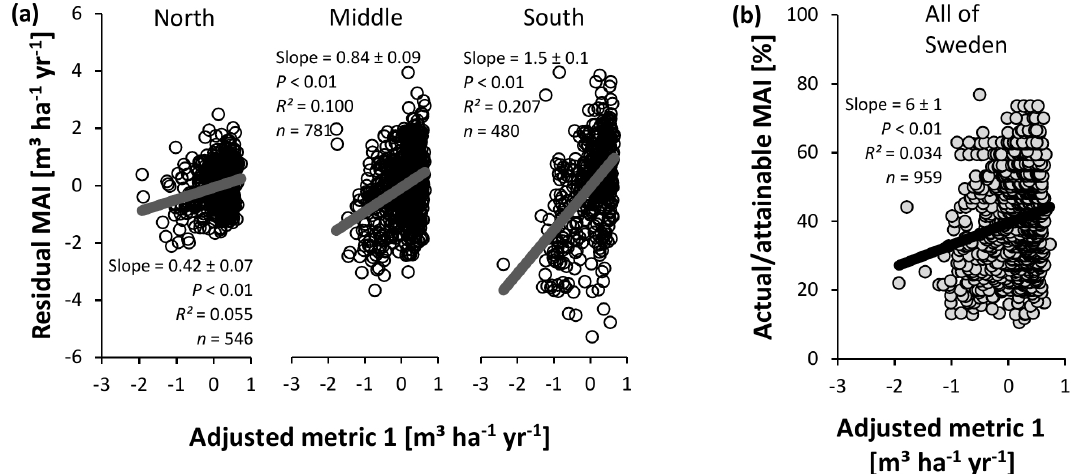
Figure 10. Evaluation of adjusted nutrient availability metric 1 for Swedish conifer forests. (a) Method 1 – association with residual mean annual increments (MAIs) of the productivity–climate regression model (Fig. 3a, Eq. S1 and Table S2), distinguishing northern, middle, and southern Sweden. (b) Method 2 – association with actual / attainable MAI (Fig. 3b) for the entire Swedish land area. Full line: significant slope ( P